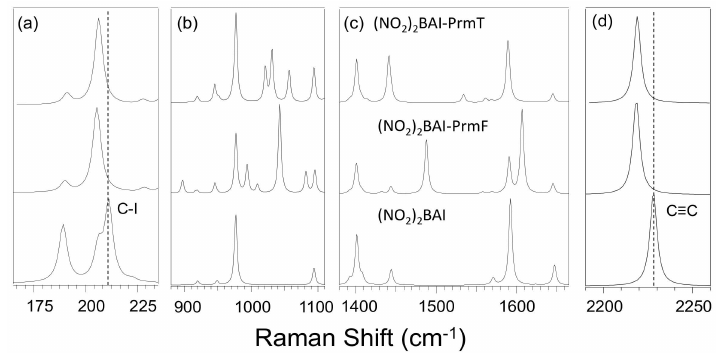
Figure 12. Simulated Raman spectra of (NO 2 ) 2 BAI (bottom), and co-crystals formed from (NO 2 ) 2 BAI with either PrmF (middle) or PrmT (top) in di ff erent spectral